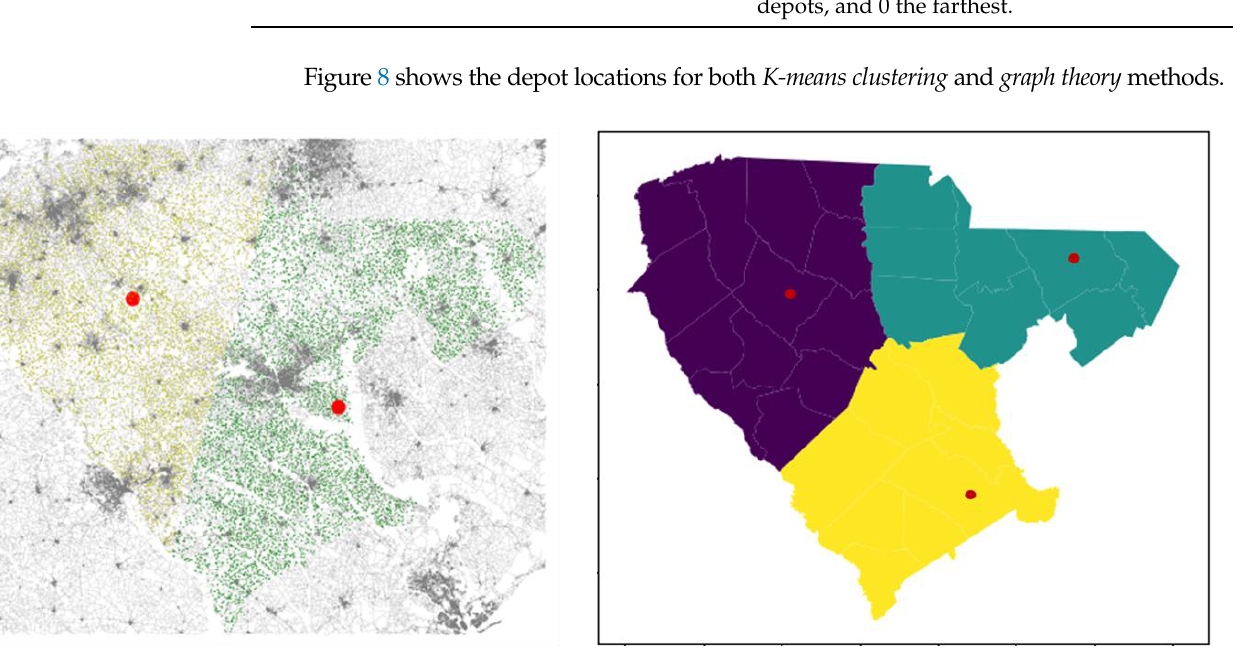
Table 2. Factors considered for updated SSI.